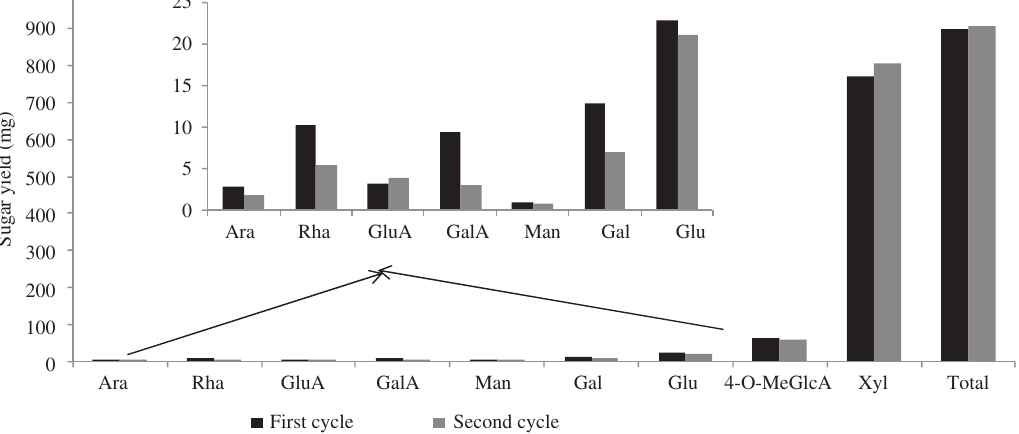
Figure 2 Hemicelluloses content (sugar yield) for the recovered material from the spent switchable ionic liquid (SIL) upon addition of methanol for the once-treated and twice-treated, using fresh SIL in both treatments at 100 ° C for 24 h and in the absence of